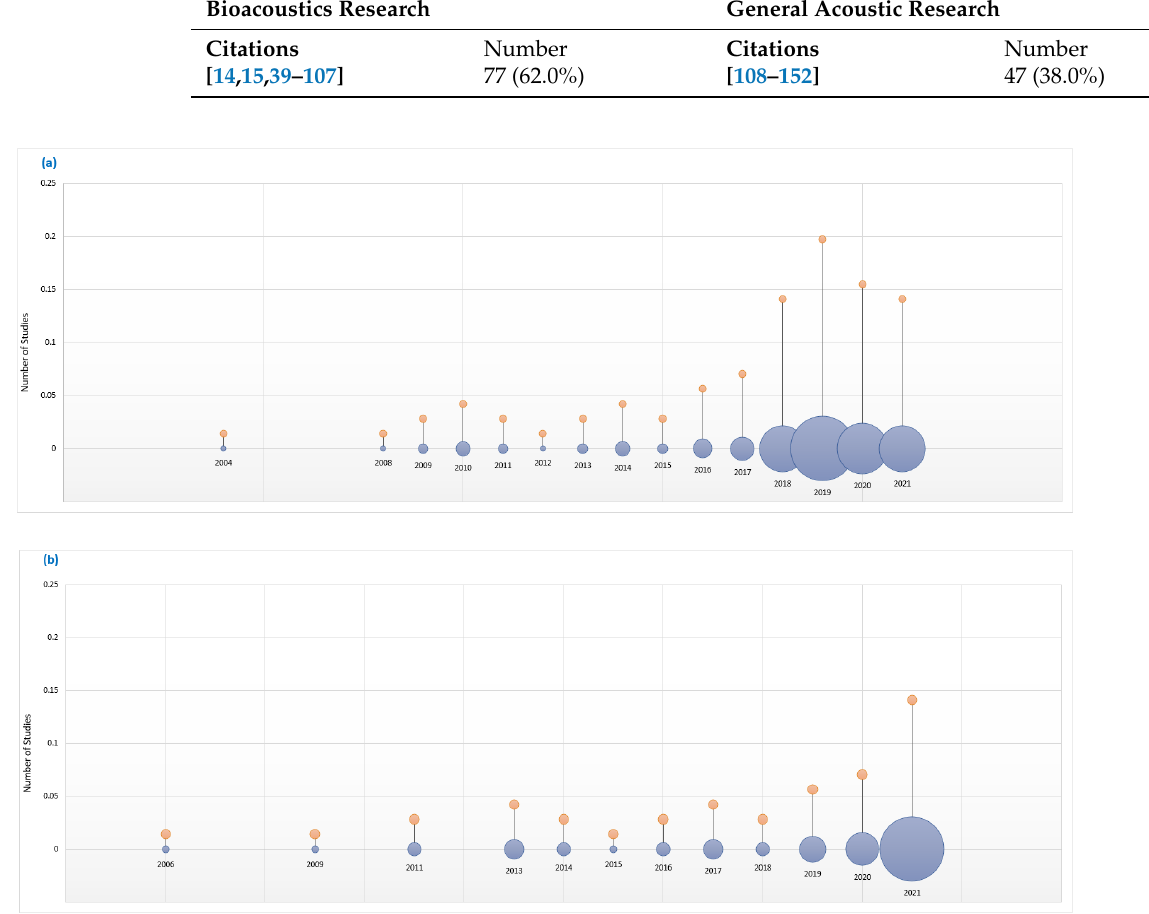
Figure 5. Progress of ( a ) bioacoustics and ( b ) general acoustics research output over the